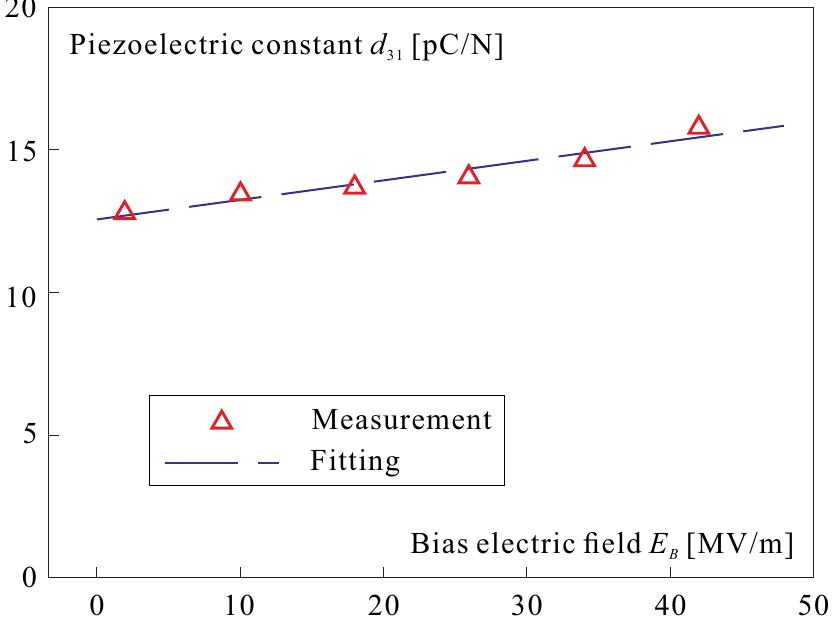
Figure 3. Piezoelectric coefficient d 31 as a function of the bias electric field. Table 1. Estimation of material parameters of